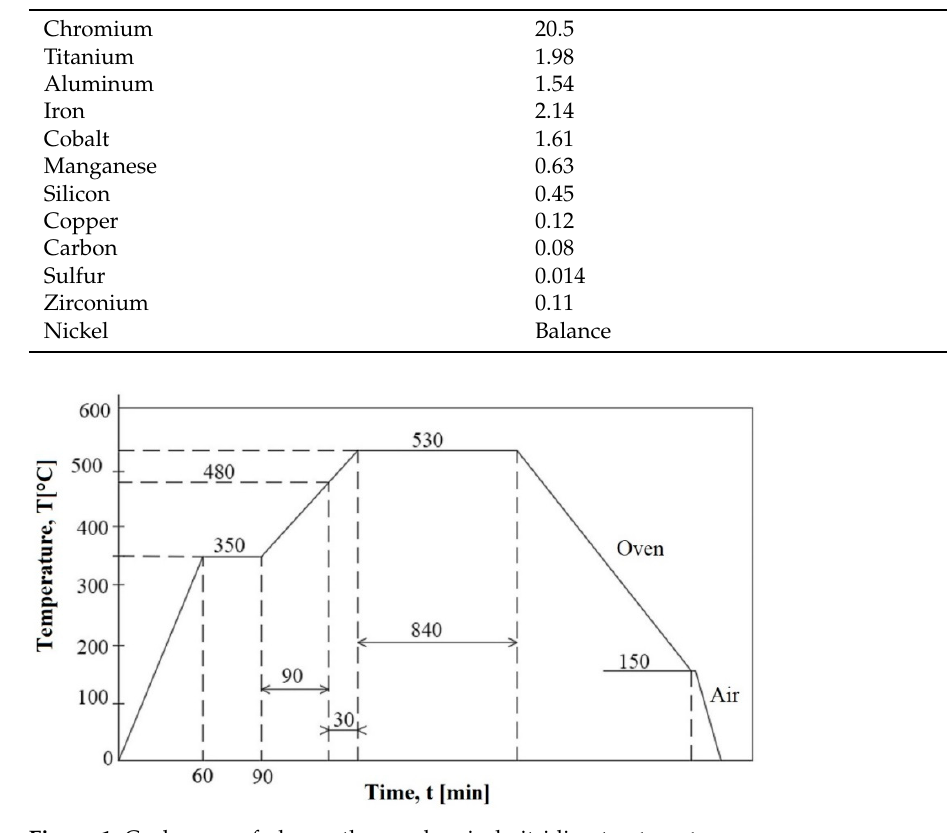
Figure 1. Cyclogram of plasma thermochemical nitriding